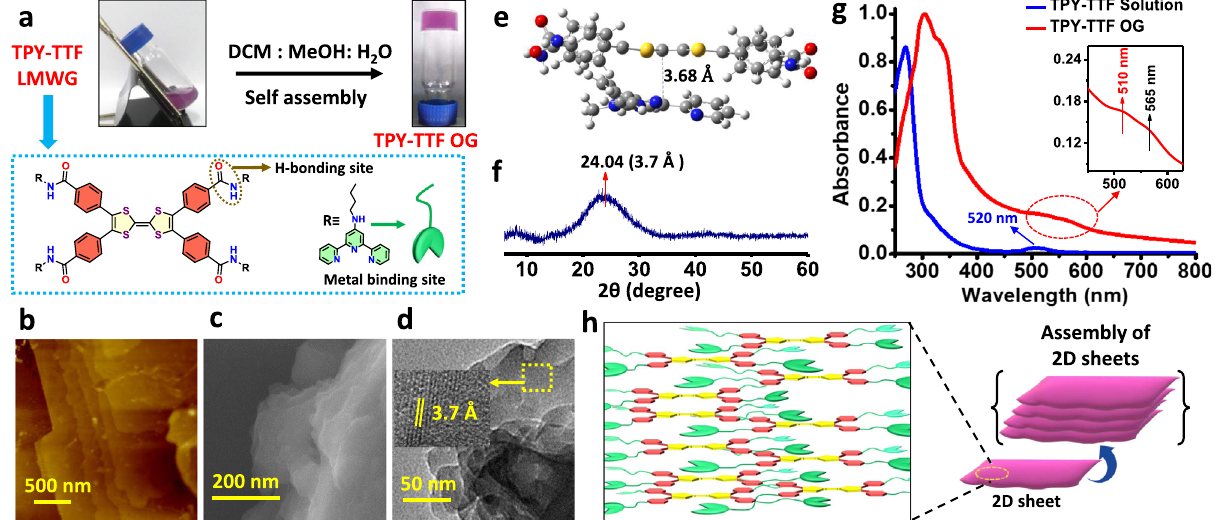
Fig. 2 Preparation and characterizations of TPY-TTF OG. a Photograph for organogel formation. Morphological analysis for xerogel. b AFM image. c FE-SEM image. d HR-TEM image (inset: showing lattice fringes). e Interplanar spacing in the optimized structure of TTF---TPY stacked model obtained through DFT calculation. f PXRD pattern for xerogel. g Comparison of absorption spectra of TPY-TTF LMWG in solution (8 × 10 − 6 M) with TPY-TTF OG xerogel state. h Pictorial representation for self-assembly in TPY-TTF OG forming layered sheet-like morphology.